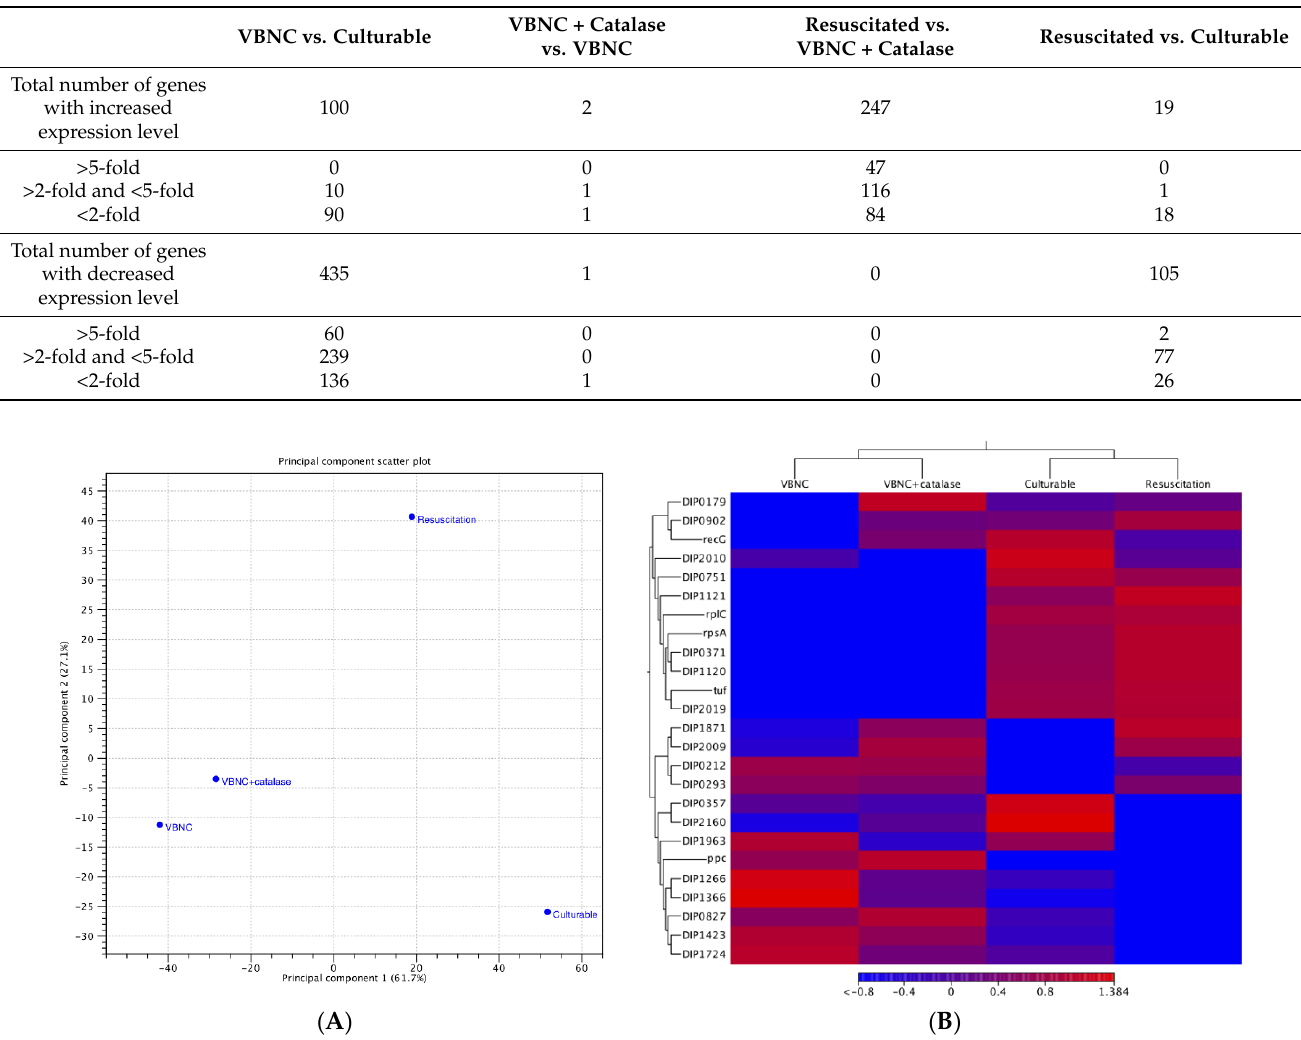
Table 1. The number of genes with changed expression level ( p < 0.05).